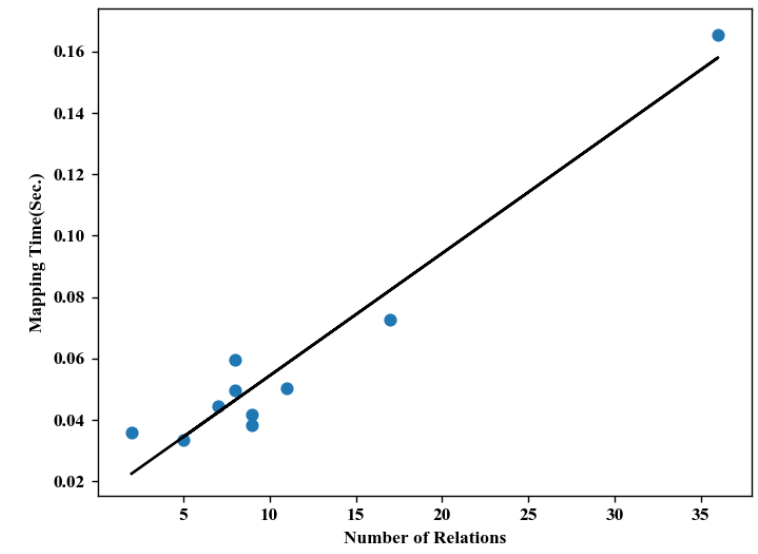
Figure 3. Mapping Time over the Number of Relations.